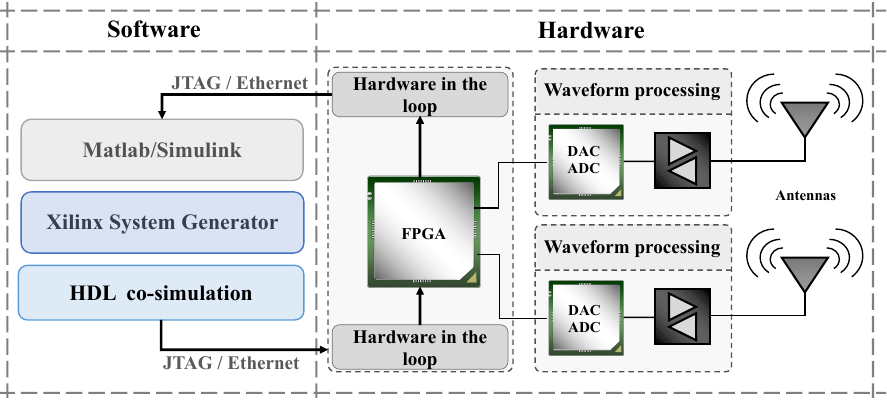
Figure 13. Co-simulation platform.